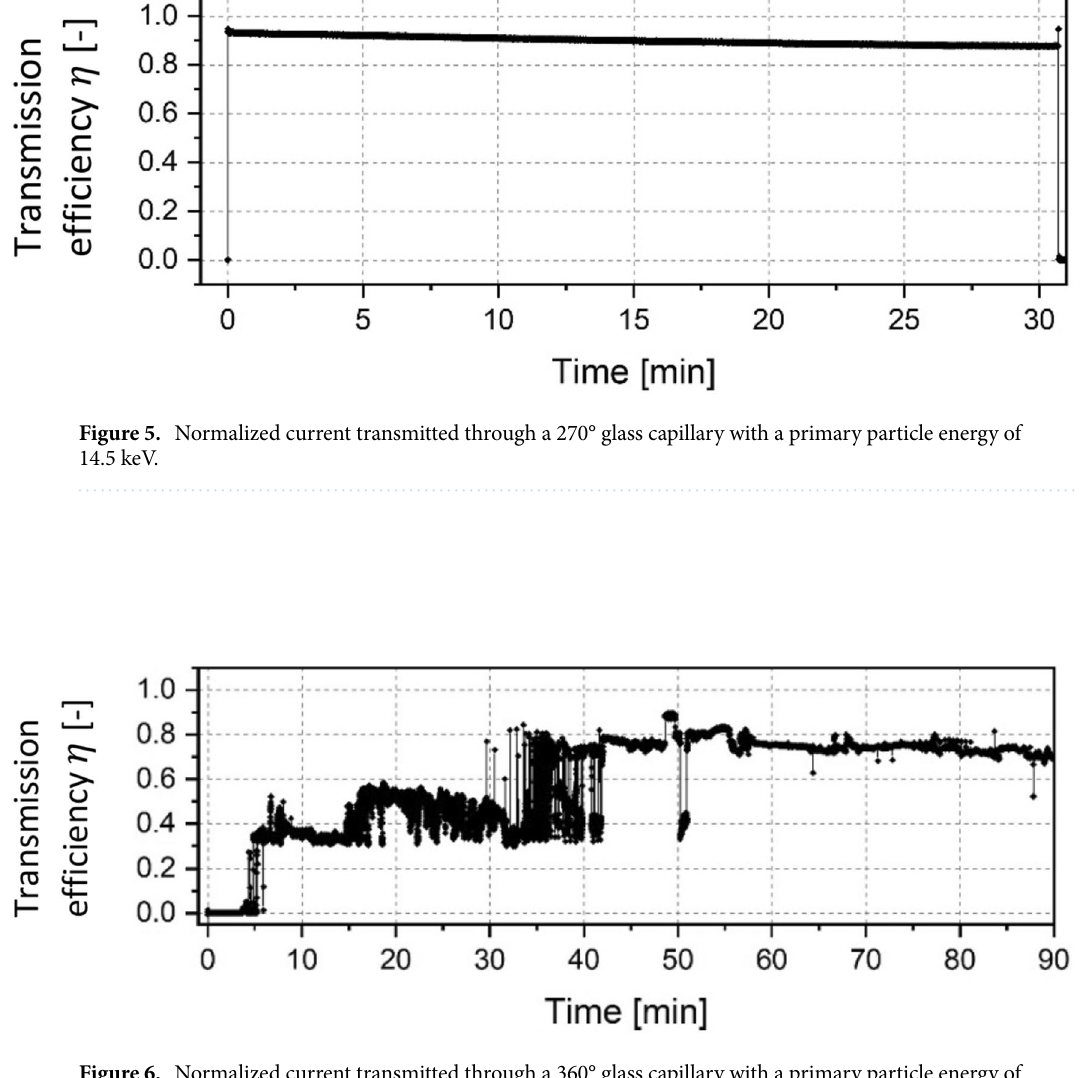
Figure 6. Normalized current transmitted through a 360° glass capillary with a primary particle energy of 14